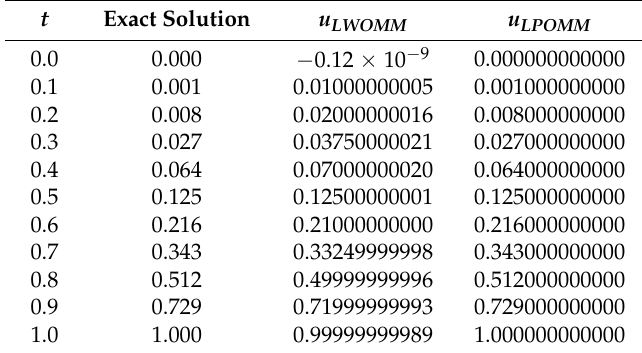
Table 3. The numerical results attained by using the introduced method in comparison to the approximate solution LPOMM and the exact solution u ( t ) in Example 2.